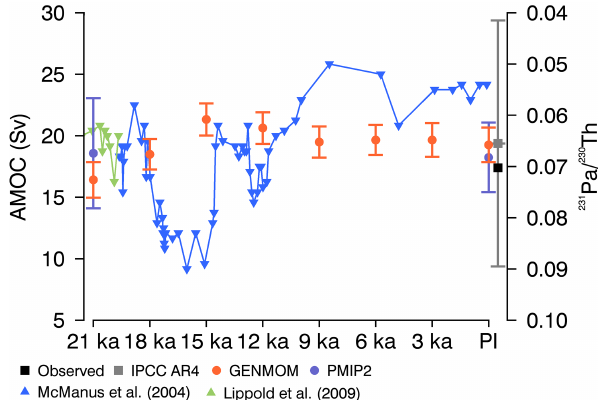
Figure 13. Simulated Atlantic Meridional Overturning Circulation (AMOC) compared to 231 Pa/ 230 Th proxy record at 33 ◦ N and other AOGCMs. Observations are from 26 . 5 ◦ N. GENMOM values are 100-year averages, with error bars representing standard deviations. The PMIP2 values represent the mean and standard deviation of the maximum AMOC from five models. The IPCC AR4 point repre- sents the mean and standard deviation from a collection of IPCC AR4 models. 231 Pa/ 230 Th data from McManus et al. (2004) and Lippold et al. (2009), observed value from Srokosz et al. (2012), PMIP2 data from Weber et al. (2007), and IPCC data from Schmit- tner et al.